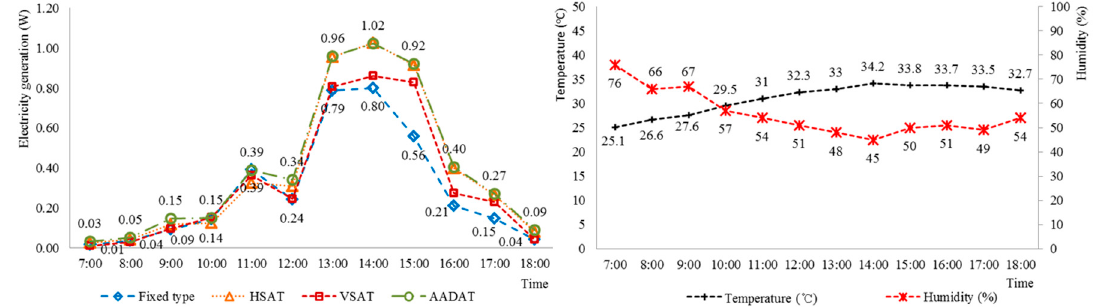
Figure 7. Electricity generation and the environmental condition of the third prototype model.